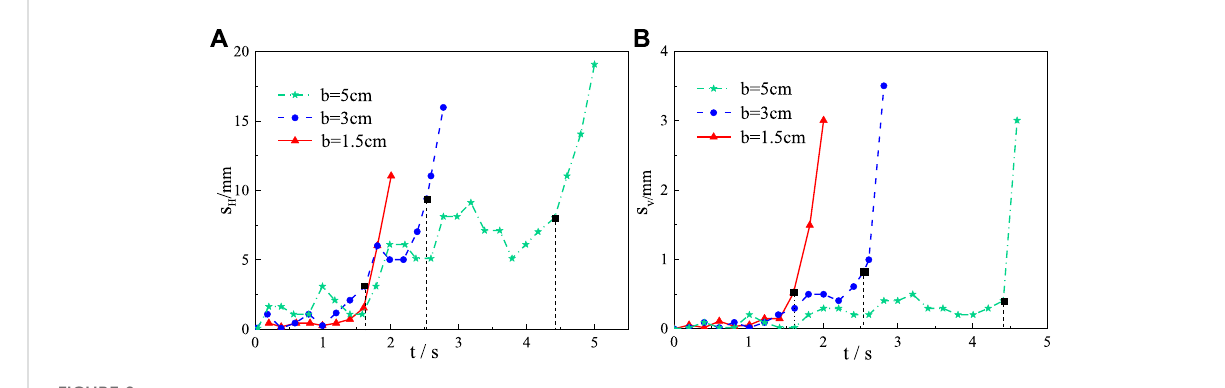
FIGURE 9 Displacement time-history curves under different rock block sizes. (A) Horizontal displacement. (B) Vertical